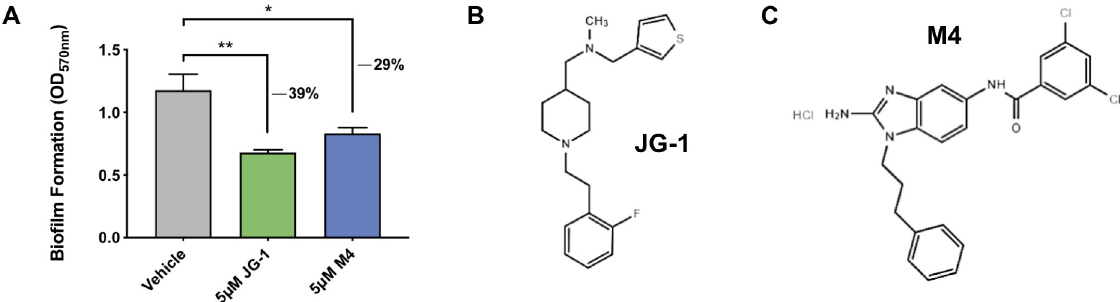
Fig 1. Identification of small molecule inhibitors of Salmonella Typhimurium biofilm formation. A. The compounds JG-1 and M4 were identified as inhibitors of Salmonella Typhimurium ( S . Typhimurium) biofilm formation via high-throughput screening of small molecule libraries. S . Typhimurium biofilms were grown in microtiter plates in the presence of various compounds at a concentration 5 μ M. Biofilm formation after 24 h was evaluated in a semi-quantitative manner using the crystal violet assay, and inhibition of biofilm formation was calculated by assessing the amount of biofilm formed relative to a vehicle control (DMSO). Data are presented as mean +/- SD; �� p < 0.01, � p < 0.05, as assessed by unpaired t-tests. B and C. Chemical structures of the small molecule biofilm inhibitors JG-1 (B) and M4 (C) .